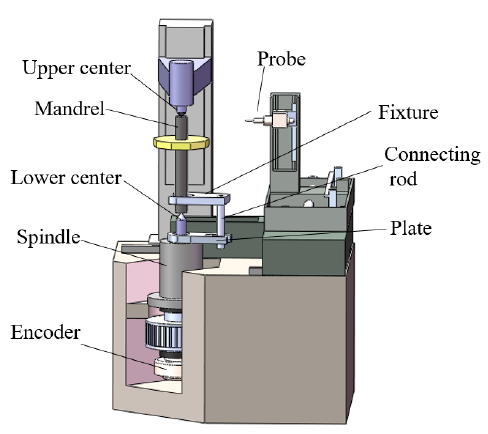
Figure 1. Mahr 891E gear measuring machine.